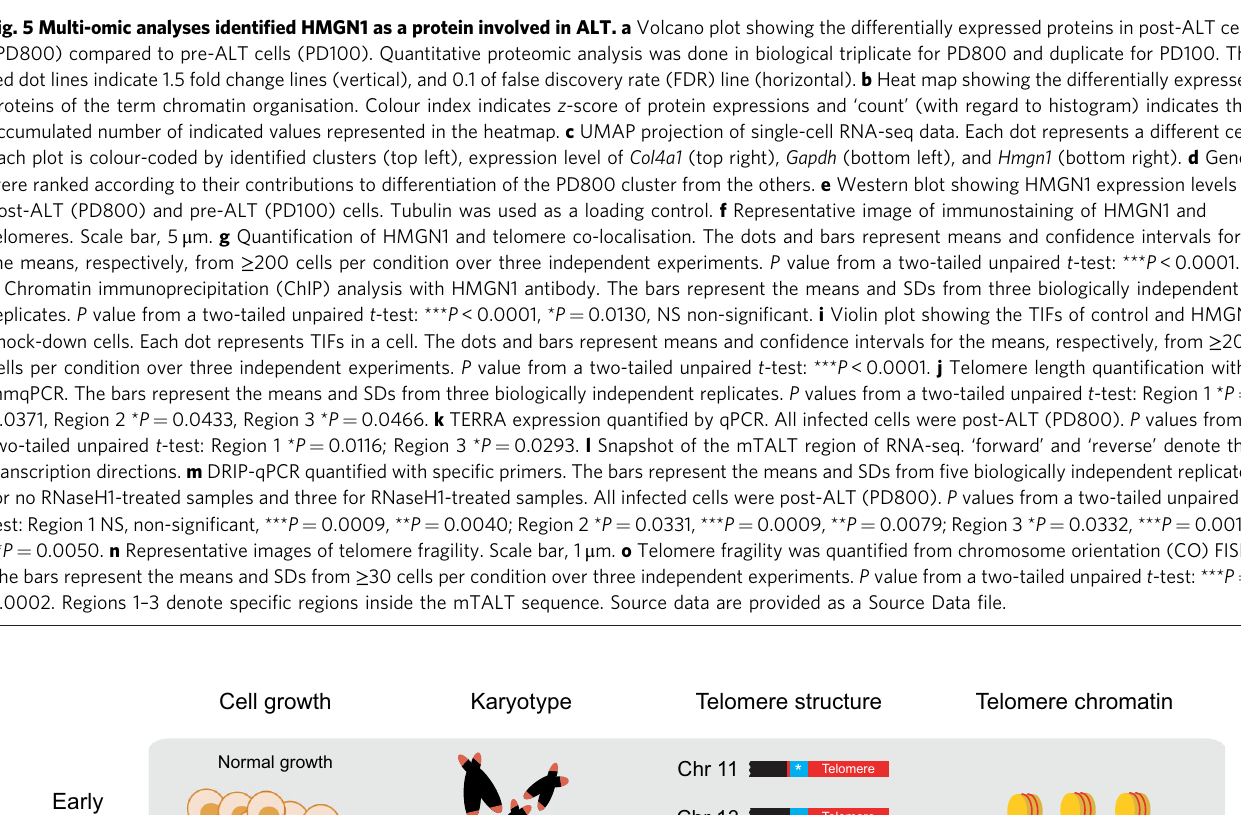
Fig. 5 Multi-omic analyses identi fi ed HMGN1 as a protein involved in ALT. a Volcano plot showing the differentially expressed proteins in post-ALT cells (PD800) compared to pre-ALT cells (PD100). Quantitative proteomic analysis was done in biological triplicate for PD800 and duplicate for PD100. The red dot lines indicate 1.5 fold change lines (vertical), and 0.1 of false discovery rate (FDR) line (horizontal). b Heat map showing the differentially expressed proteins of the term chromatin organisation. Colour index indicates z -score of protein expressions and ‘ count ’ (with regard to histogram) indicates the accumulated number of indicated values represented in the heatmap. c UMAP projection of single-cell RNA-seq data. Each dot represents a different cell. Each plot is colour-coded by identi fi ed clusters (top left), expression level of Col4a1 (top right), Gapdh (bottom left), and Hmgn1 (bottom right). d Genes were ranked according to their contributions to differentiation of the PD800 cluster from the others. e Western blot showing HMGN1 expression levels in post-ALT (PD800) and pre-ALT (PD100) cells. Tubulin was used as a loading control. f Representative image of immunostaining of HMGN1 and telomeres. Scale bar, 5 μ m. g Quanti fi cation of HMGN1 and telomere co-localisation. The dots and bars represent means and con fi dence intervals for the means, respectively, from ≥ 200 cells per condition over three independent experiments. P value from a two-tailed unpaired t -test: *** P < 0.0001. h Chromatin immunoprecipitation (ChIP) analysis with HMGN1 antibody. The bars represent the means and SDs from three biologically independent replicates. P value from a two-tailed unpaired t -test: *** P < 0.0001, * P = 0.0130, NS non-signi fi cant. i Violin plot showing the TIFs of control and HMGN1 knock-down cells. Each dot represents TIFs in a cell. The dots and bars represent means and con fi dence intervals for the means, respectively, from ≥ 200 cells per condition over three independent experiments. P value from a two-tailed unpaired t -test: *** P < 0.0001. j Telomere length quanti fi cation with mmqPCR. The bars represent the means and SDs from three biologically independent replicates. P values from a two-tailed unpaired t -test: Region 1 * P = 0.0371, Region 2 * P = 0.0433, Region 3 * P = 0.0466. k TERRA expression quanti fi ed by qPCR. All infected cells were post-ALT (PD800). P values from a two-tailed unpaired t -test: Region 1 * P = 0.0116; Region 3 * P = 0.0293. l Snapshot of the mTALT region of RNA-seq. ‘ forward ’ and ‘ reverse ’ denote the transcription directions. m DRIP-qPCR quanti fi ed with speci fi c primers. The bars represent the means and SDs from fi ve biologically independent replicates for no RNaseH1-treated samples and three for RNaseH1-treated samples. All infected cells were post-ALT (PD800). P values from a two-tailed unpaired t -